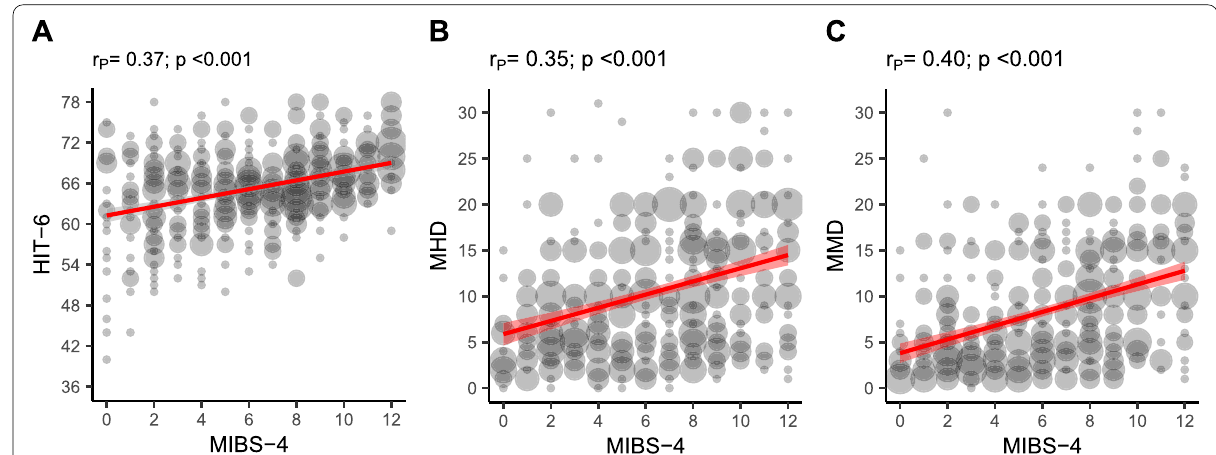
Fig. 1 Relationship between MIBS-4 and A HIT-6, B MHD, and C MMD. The estimated linear association and 95% CI between the two variables are shown in red. Bubble size is proportionate to the number of observations